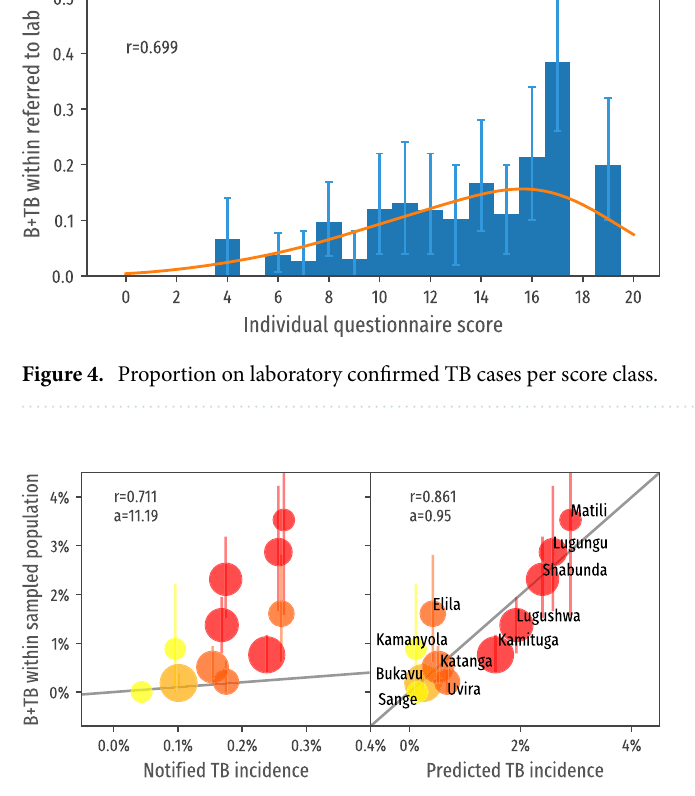
Figure 5. Correlation of the predicted incidence with the measured incidence within sampled population (right). Note the high value of the correlation coefficient r . The parameter a represent the slope of the fitting line. As a term of comparison, the correlation of the incidence extracted from the health system reports with the measured incidence within the sampled population (left). Note in this case the lower correlation coefficient and the slope of the fitting line (the measured incidence surpass 10x the incidence of reported